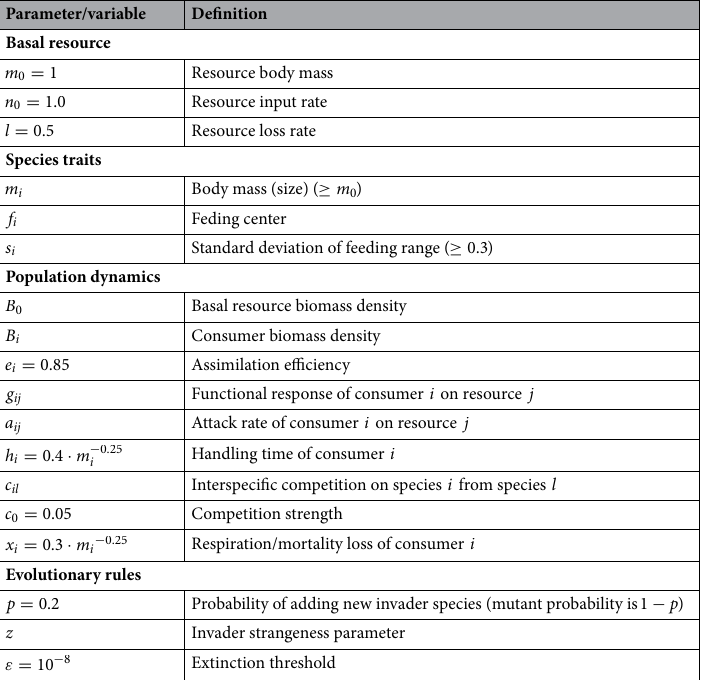
Table 2. List of model parameters and variables. If no value is provided for a parameter, it is